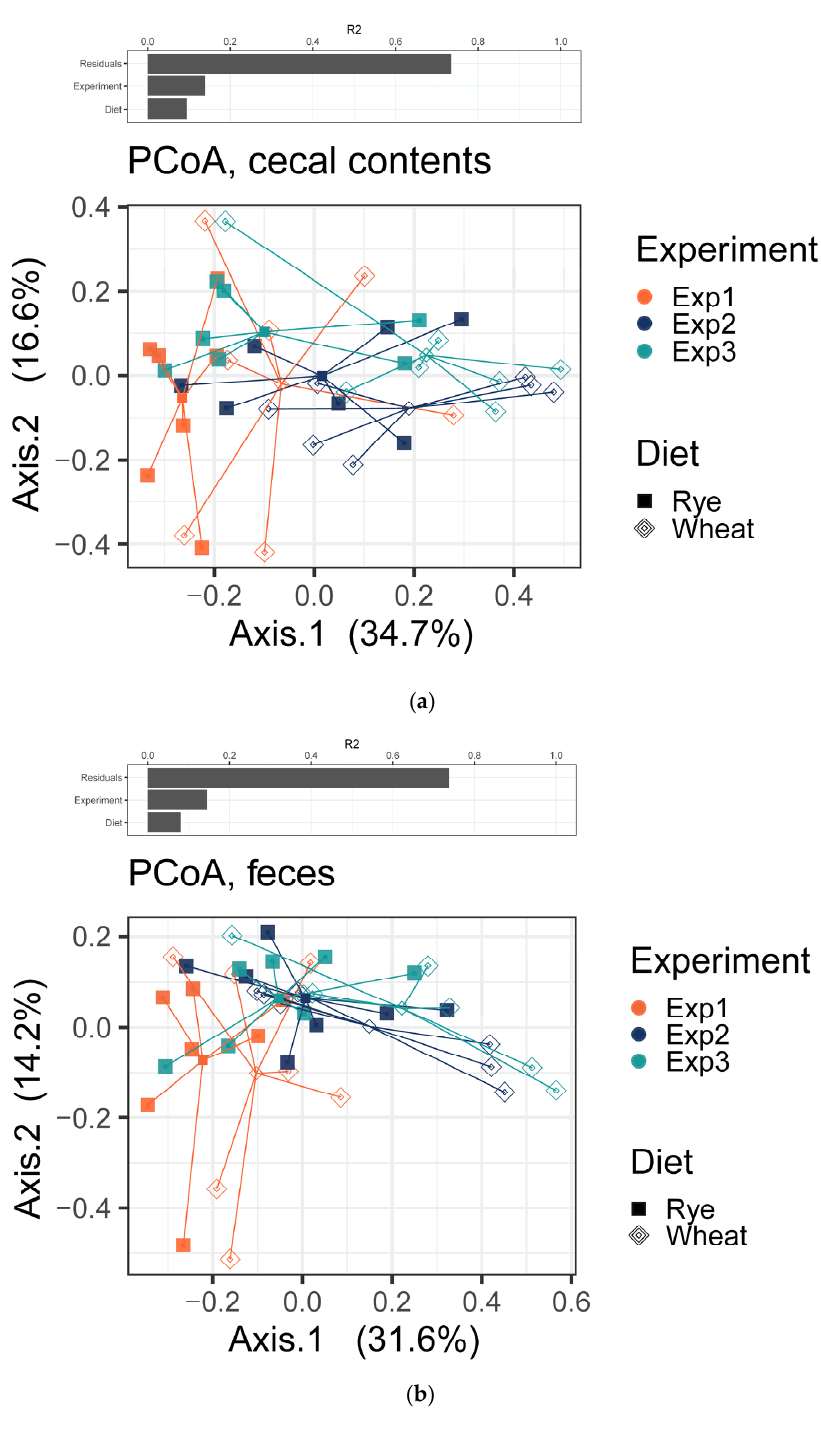
Figure 2. A permutational multivariate analysis of variance (PERMANOVA) on Bray–Curtis distances was used to quantify the contribution of the factors Experiment and Diet to the differences in microbial composition of the samples (above). A Bray–Curtis dissimilarity-based principal coordinate analysis (PCoA) was performed on ( a ) cecal contents and ( b ) feces of pigs fed with either rye- or wheat-containing diets. Different colors represent samples obtained from different experiments. Different point shapes represent samples of pigs receiving different diets. Lines connect samples obtained from the same groups (below). Microbiota of cecal contents were dominated at the phylum level by Firmicutes (76.6% ± 13.0) and Bacteroidetes (20.6% ± 12.8), followed by Actinobacteria (1.2% ± 2.60). Fecal microbiota was dominated by Firmicutes (65.1% ±10.4) and Bacteroidetes (30.0% ± 11.4) as well, followed by Spirochaetae (2.27% ± 3.10) and Actinobacteria (1.14% ± 2.71). The relative abundances of bacterial phyla in every sample are shown in Figure 3.